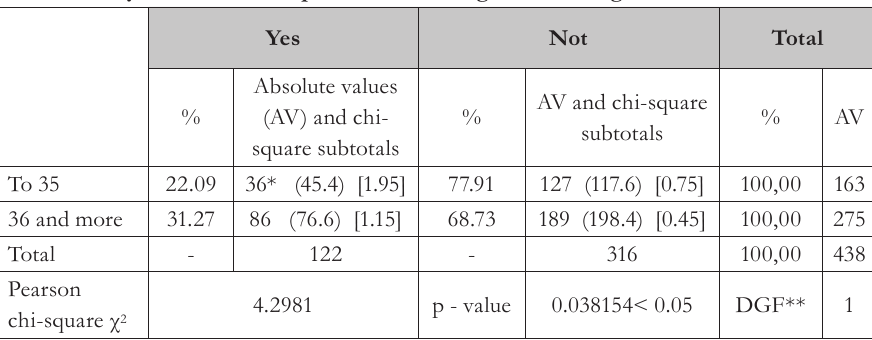
Table 3 Pearson chi-square calculation according to the age Do you know how to protect the firm against a change of interest rate Yes Not Total Absolute values AV and chi-square % (AV) and chi- % square subtotals